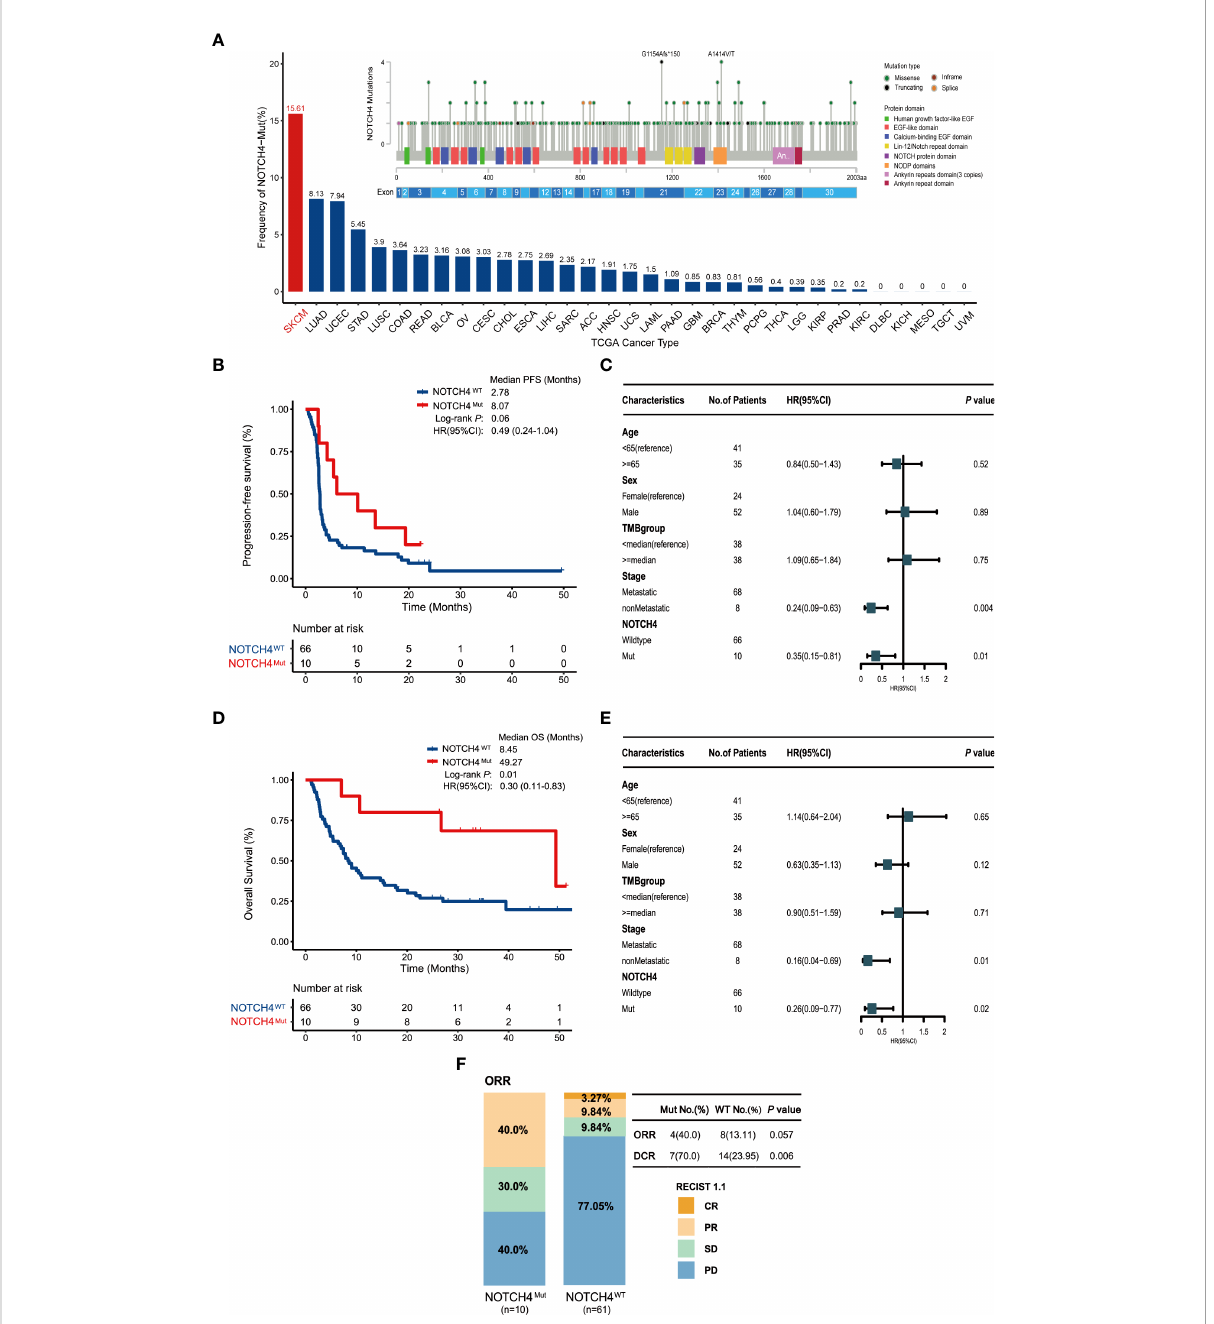
FIGURE 2 NOTCH4 mutation status and the association between NOTCH4 mutations and clinical outcomes for immunotherapy in the discovery cohort (N = 76). (A) The frequency of NOTCH4 mutations across 33 types of cancer in the TCGA. The numbers above the barplot indicate the alteration frequency. (B) Kaplan – Meier survival analysis comparing PFS between NOTCH4-Mut and NOTCH4-Wt patients in the discovery cohort. (C) Multivariate Cox regression analysis of NOTCH4 mutations with age, gender, stage (metastasis, means distant metastases, including IV stage with M1a, M1b, and M1c vs non-metastasis, means without distant metastases including stage IIIC and IV stage with M0) and TMB (<median vs ≥ median= status were taken into account. Square data markers indicate estimated hazard ratios. Error bars represent 95% CIs. (D) Kaplan – Meier survival analysis comparing OS between NOTCH4-Mut and NOTCH4-Wt patients in the discovery cohort. (E) Multivariate Cox regression analysis of NOTCH4 mutations with age, gender, stage, and TMB status was taken into account. (F) The ratio of patients